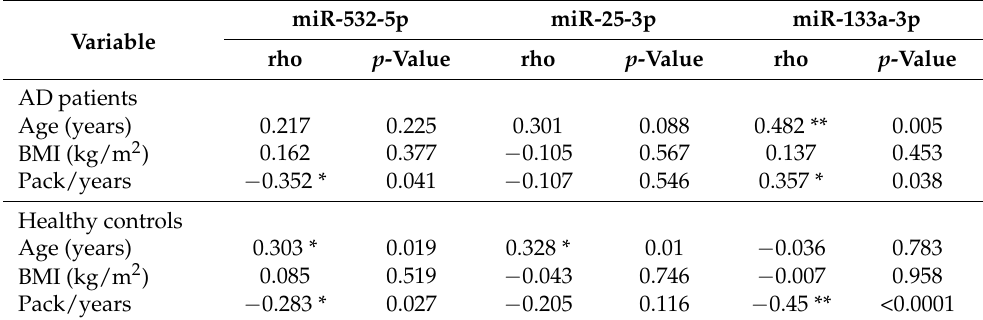
Table 3. Spearman correlation analysis for miRNA expression levels and continuous assessed variables.